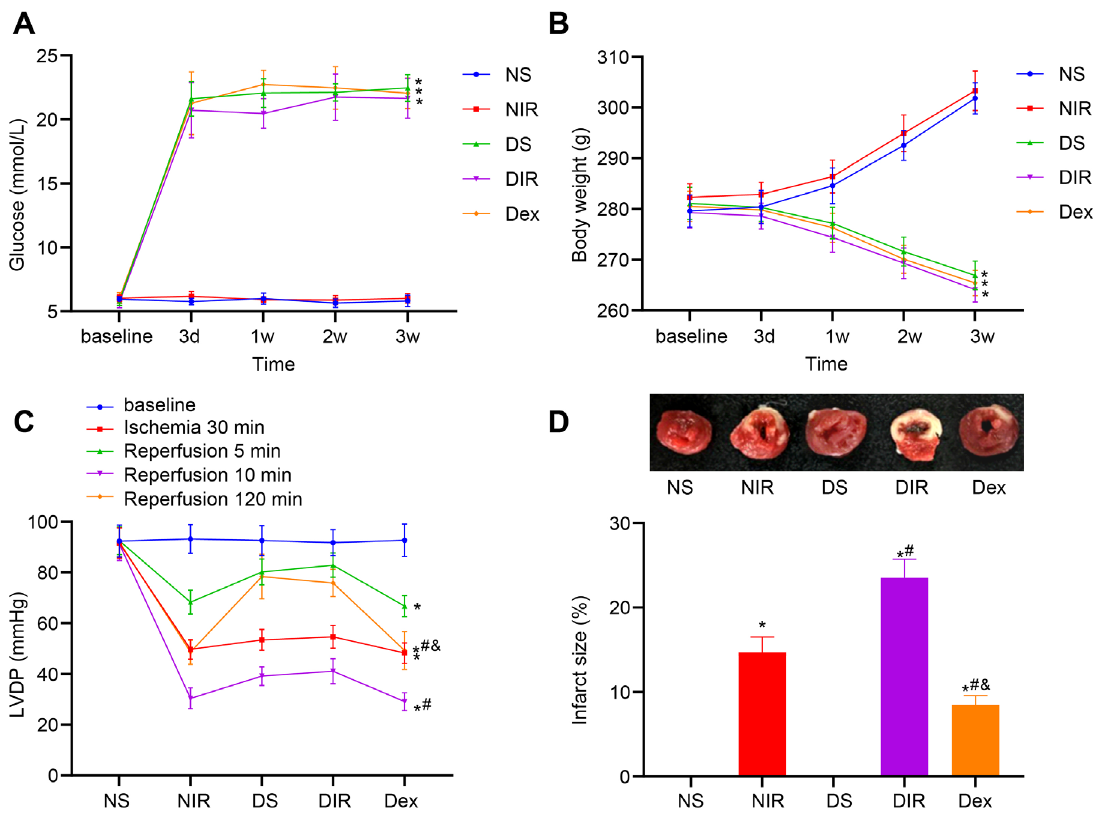
Fig. 2 - Identification of myocardial ischemia/reperfusion (MIR) injury in diabetic mouse models. A-B) Glucose (A) and body weights (B) of diabetic rats at three days, one week, two weeks, and three weeks after streptozocin induction. C) Left ventricular developed pressure (LVDP) level in each group after MIR (n=6). D) Infarct’s size of each group after MIR observed by 2, 3, 5-triphenyltetrazolium chloride staining (n=3). One-way analysis of variance (ANOVA) and repeated ANOVA were employed to verify statistical significance. * P<0.05, compared with the non-diabetic sham (NS) group; # P<0.05, compared with the diabetic sham (DS) group; & P<0.05, compared with the diabetic + ischemia/reperfusion (DIR) group. Dex=dexmedetomidine; NIR=non-diabetic +